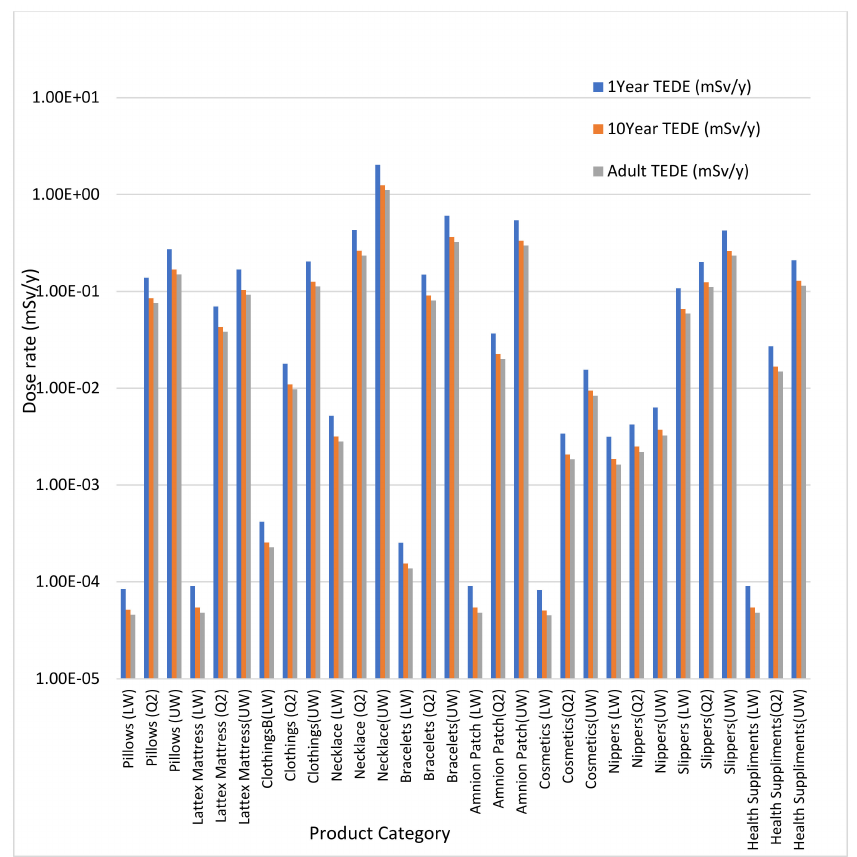
Figure 2. Age-dependent total effective dose